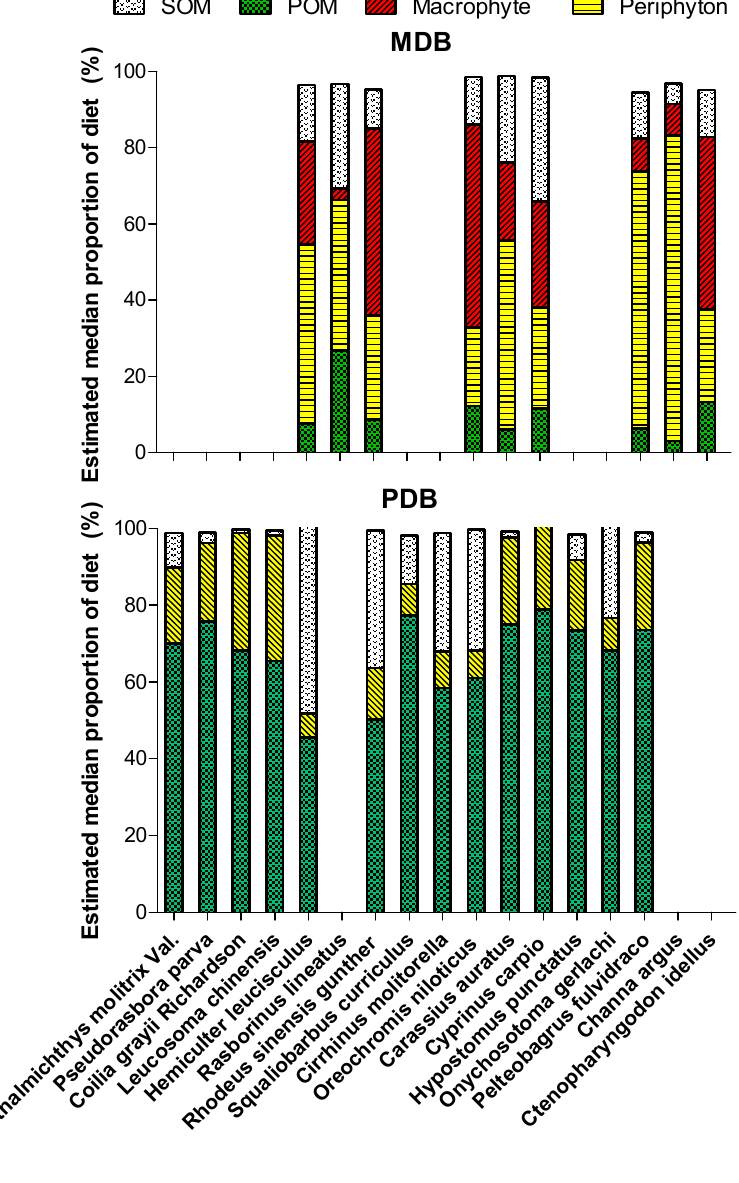
Figure 6. Mixing model estimates of the median proportion of fish diets from basal carbon resources in MDB and PDB based on MixSIR mixing models.